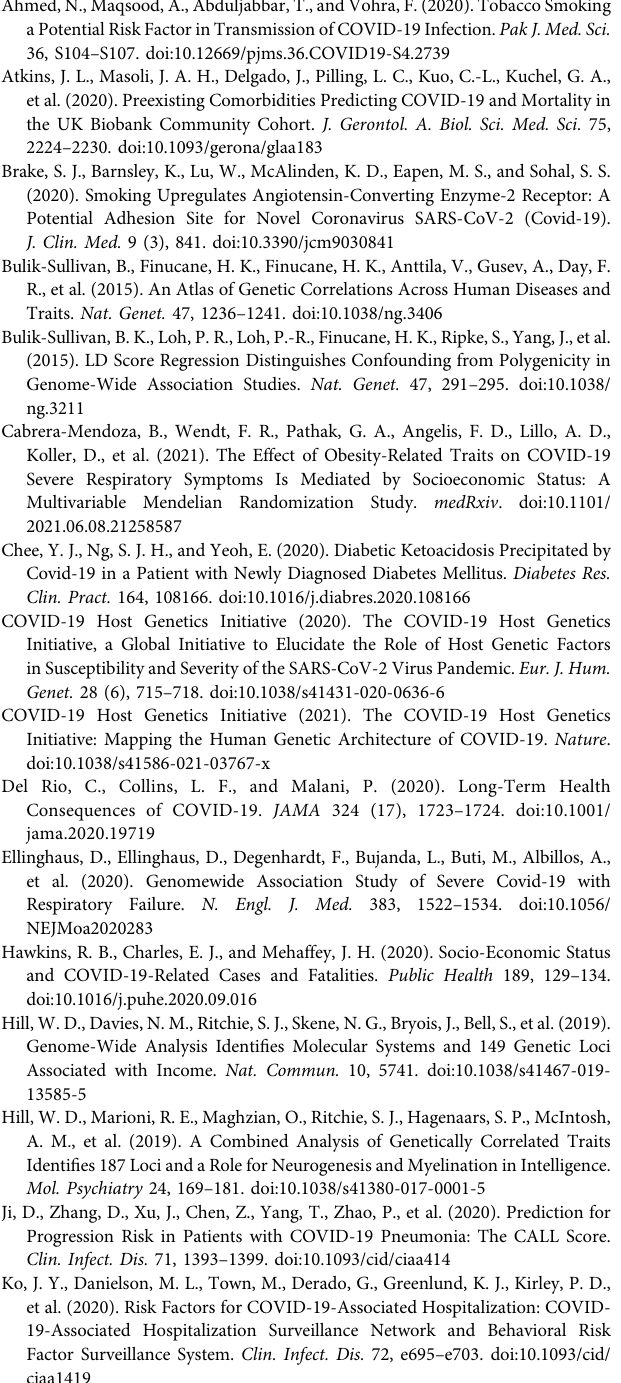
signi fi cance (p < 0.05). Ancestry assignments are: AFR (African), AMR (admixed American), CSA (Central/South Asian), EAS (East Asian), EUR (European), MID (Middle Eastern), Meta (trans-ancestry meta-analysis). MAF denotes the SNP minor allele